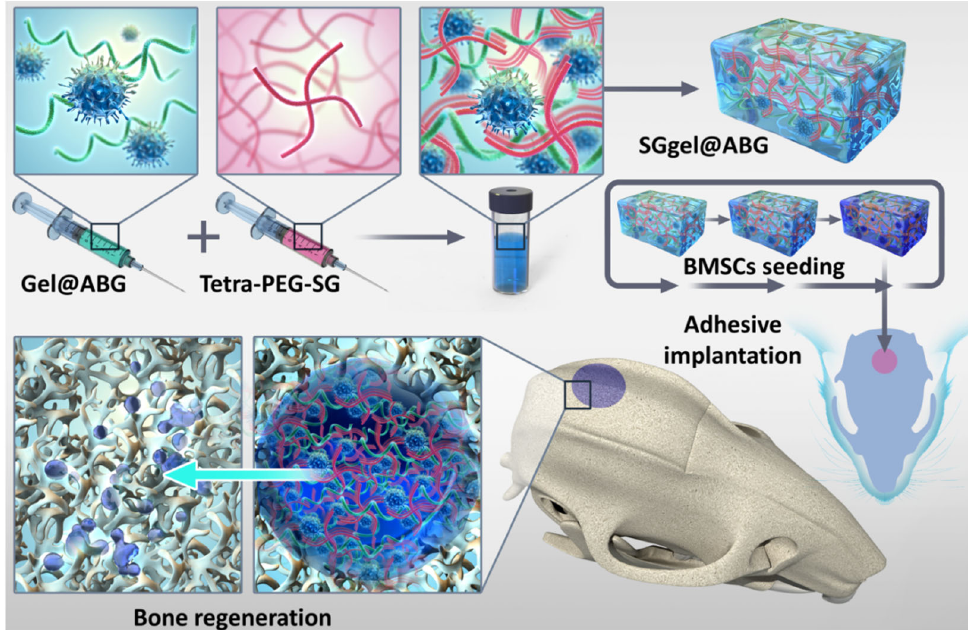
Figure 1. Schematic illustration of the fabrication procedures of SGgel@ABG composite hydrogel for calvaria bone defects repair.